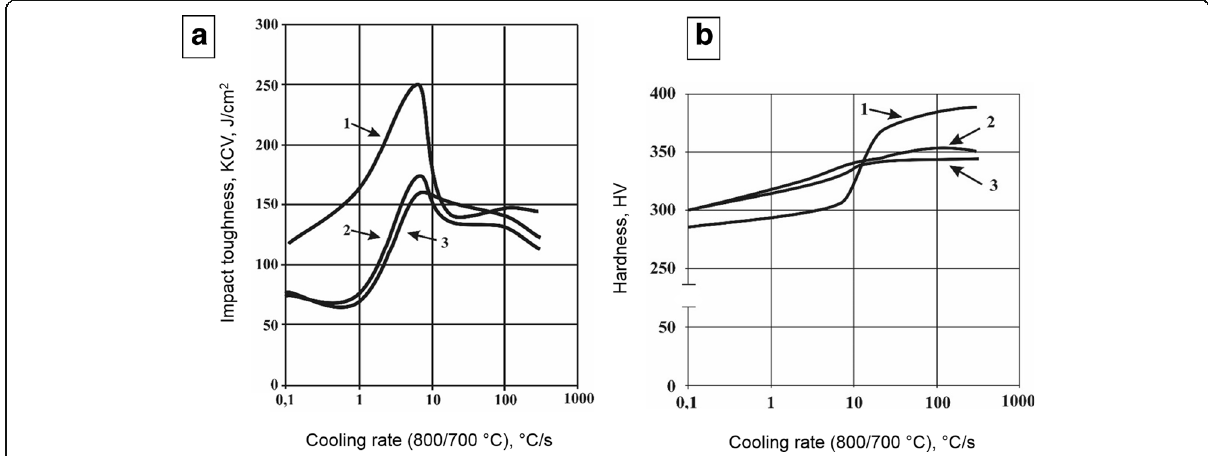
Fig. 3 Change of hardness ( a ) and toughness ( b ) in the HAZ region versus temperature test samples of steel 10XN3MD at different cooling rates after welding before and after tempering at 600 (2) and 640 °C (3), as well as after simulation of heating